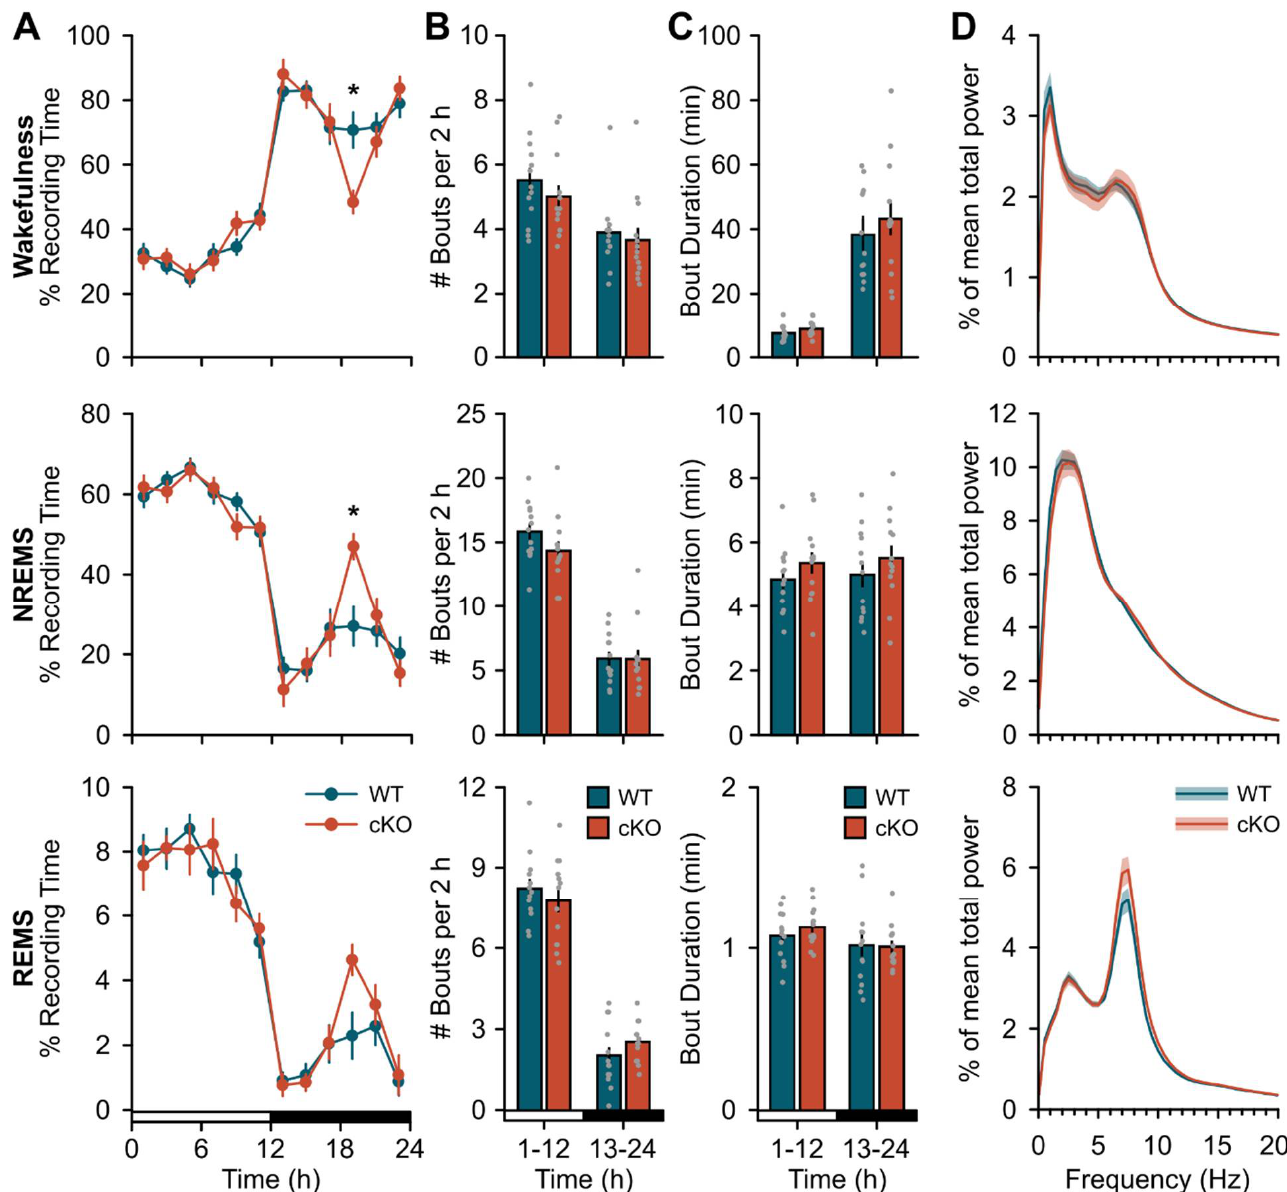
Figure 1. Conditional deletion of astroglial β2-ARs increases duration of dark period siesta. ( A ) Time spent in wakefulness (top), NREMS (middle), and REMS (bottom) expressed as a percentage of total recording time in 2 h bins. ( B ) Average bout frequency and ( C ) bout duration for wakefulness (top), NREMS (middle), and REMS (bottom) during the 12 h light and dark periods. ( D ) Normalized EEG spectral power for wakefulness (top), NREMS (middle), and REMS (bottom) over 24 h. Open and closed bars on the x -axis denote the light and dark periods, respectively. Values are means ± SE from n = 13 WT and n = 13 cKO mice. * p < 0.05 (repeated measures ANOVA). 2.2. Changes in Sleep Homeostasis Following cKO of Astroglial β2-ARs